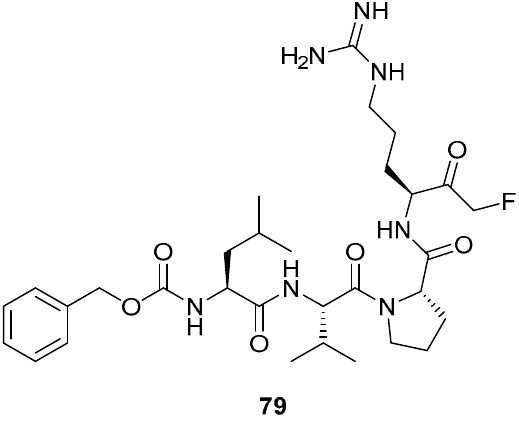
Figure 4. Peptidyl FMK capable of inhibiting the paracaspase enzyme MALT1 [3].